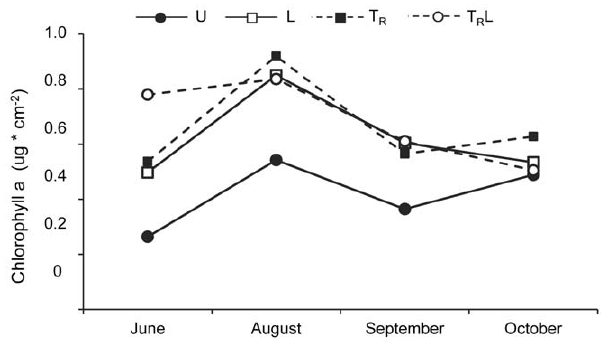
Figure 5. Chlorophyll a. Chlorophyll a (ug/cm 2 ) over the whole season in unmanipulated (U), light (L), terrestrial invertebrate reduction (T R ), terrestrial invertebrate reduction 6 light (T R L) treatments. Error bars have been omitted for